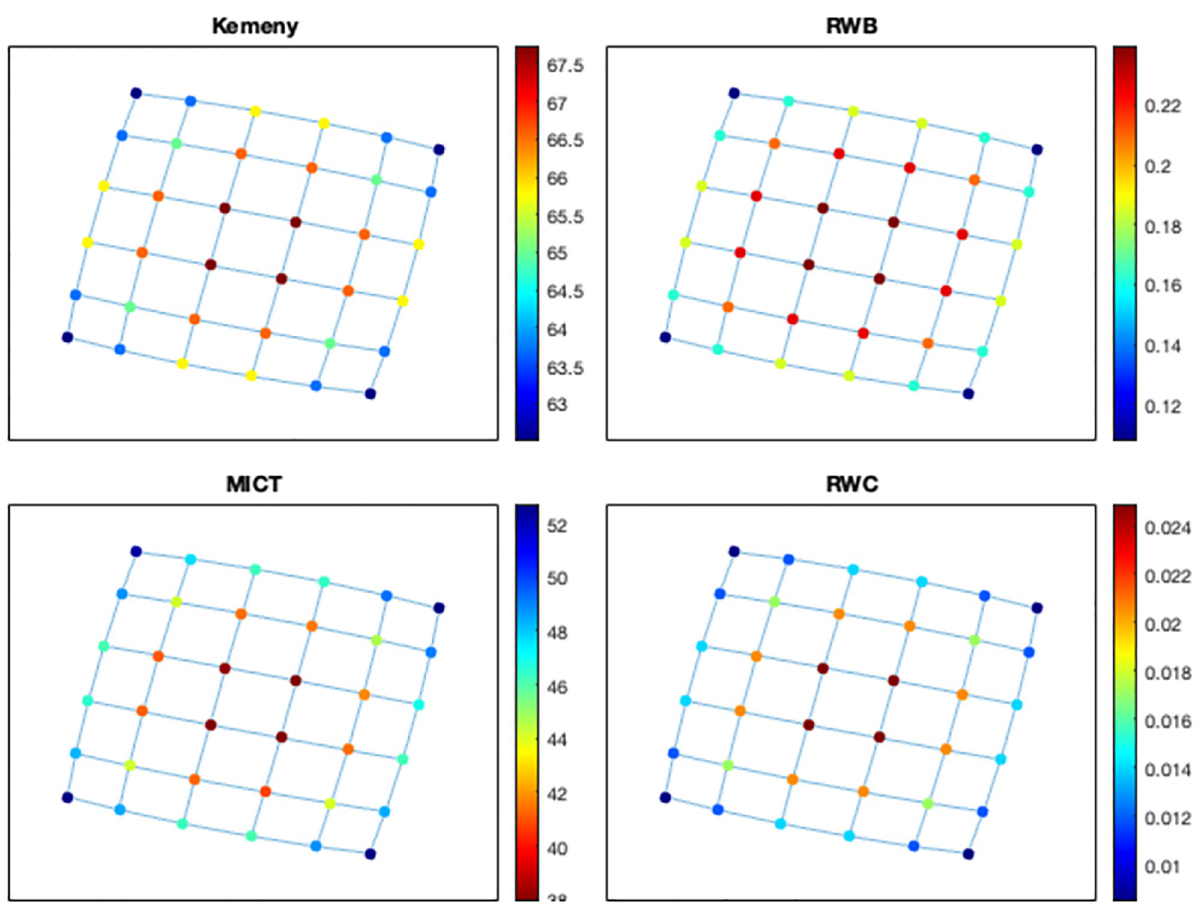
Fig 6. Ranking nodes in L (6,